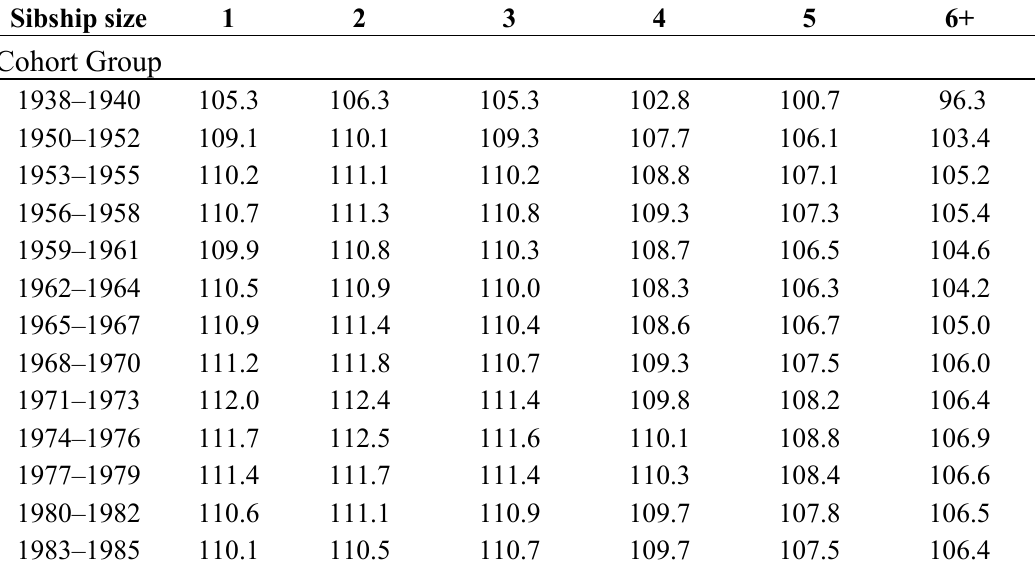
Table 1. Intelligence test scores (IQ units) by conscript birth cohort group and sibship size. Sibship